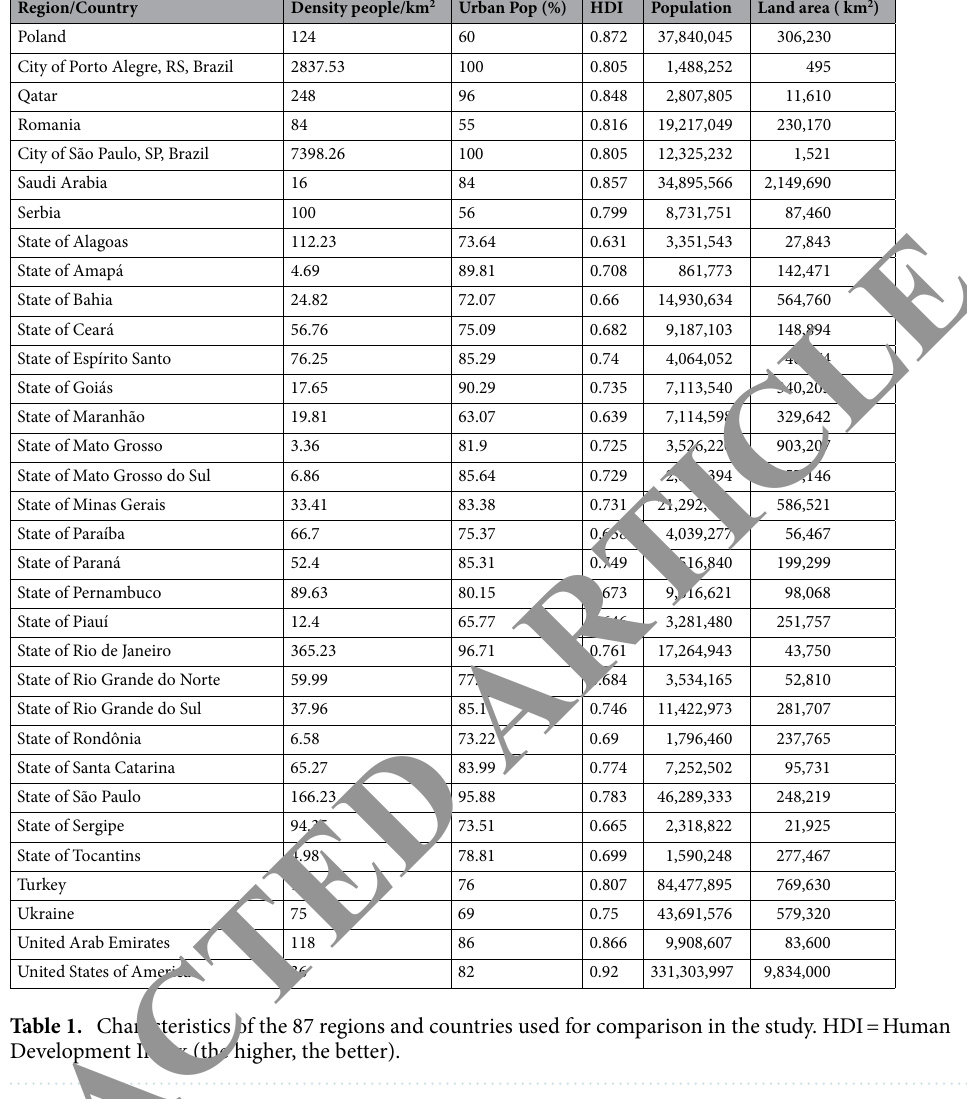
Table 1. Characteristics of the 87 regions and countries used for comparison in the study. HDI = Human Development Index (the higher, the